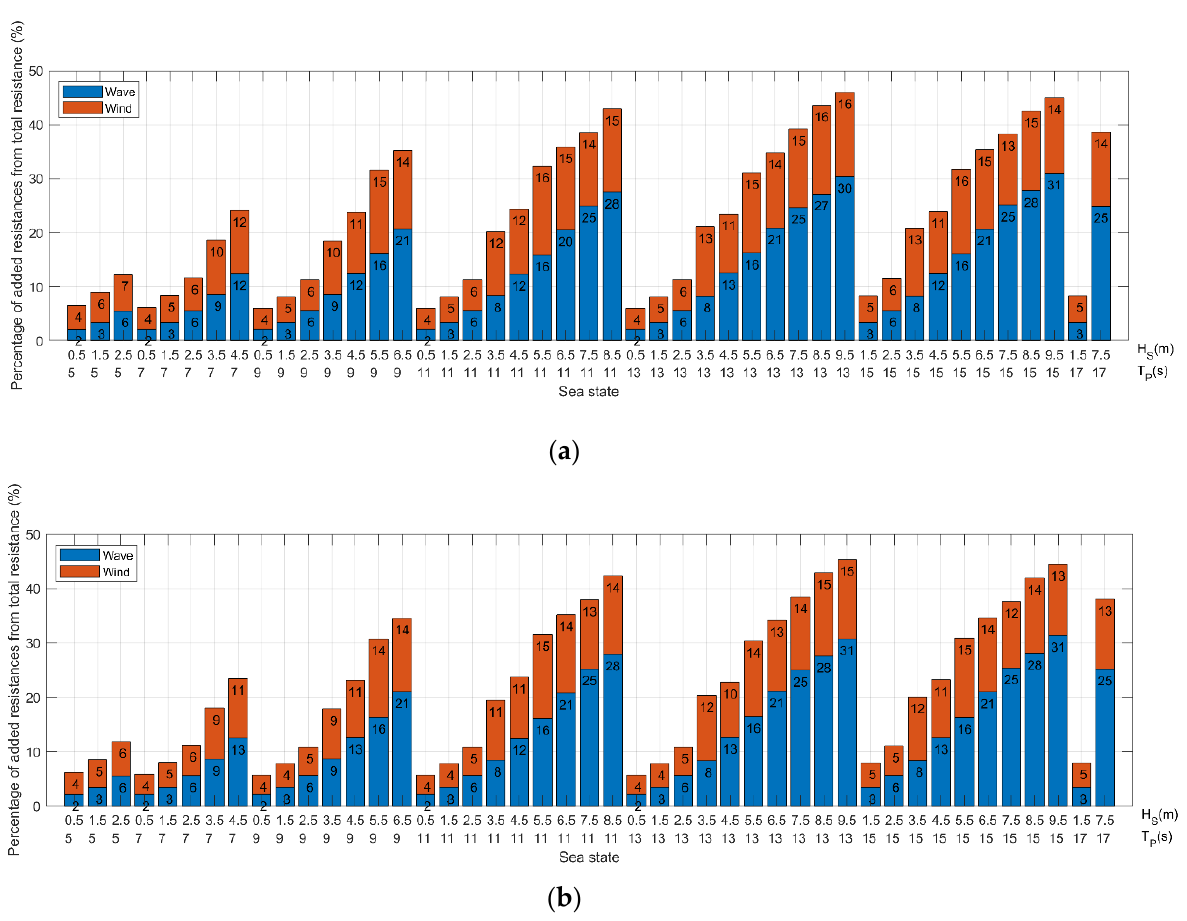
Figure 7. Percentage of added resistance from total resistance for different sea states. Hull rough- ness: ( a ) 0.15 mm; ( b ) 0.55 mm. ( a ) 0.15 mm; ( b ) 0.55